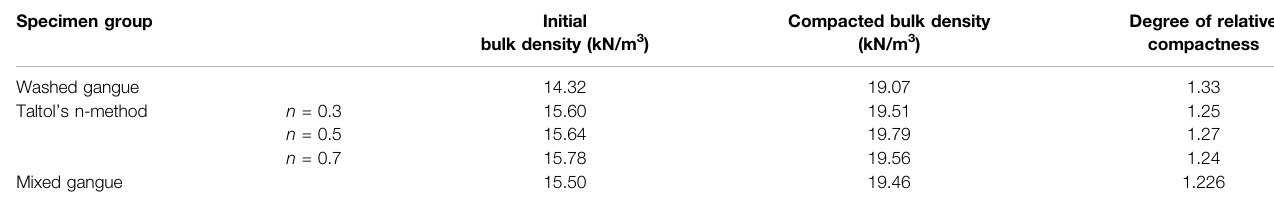
TABLE 9 | Variation table of the bulk